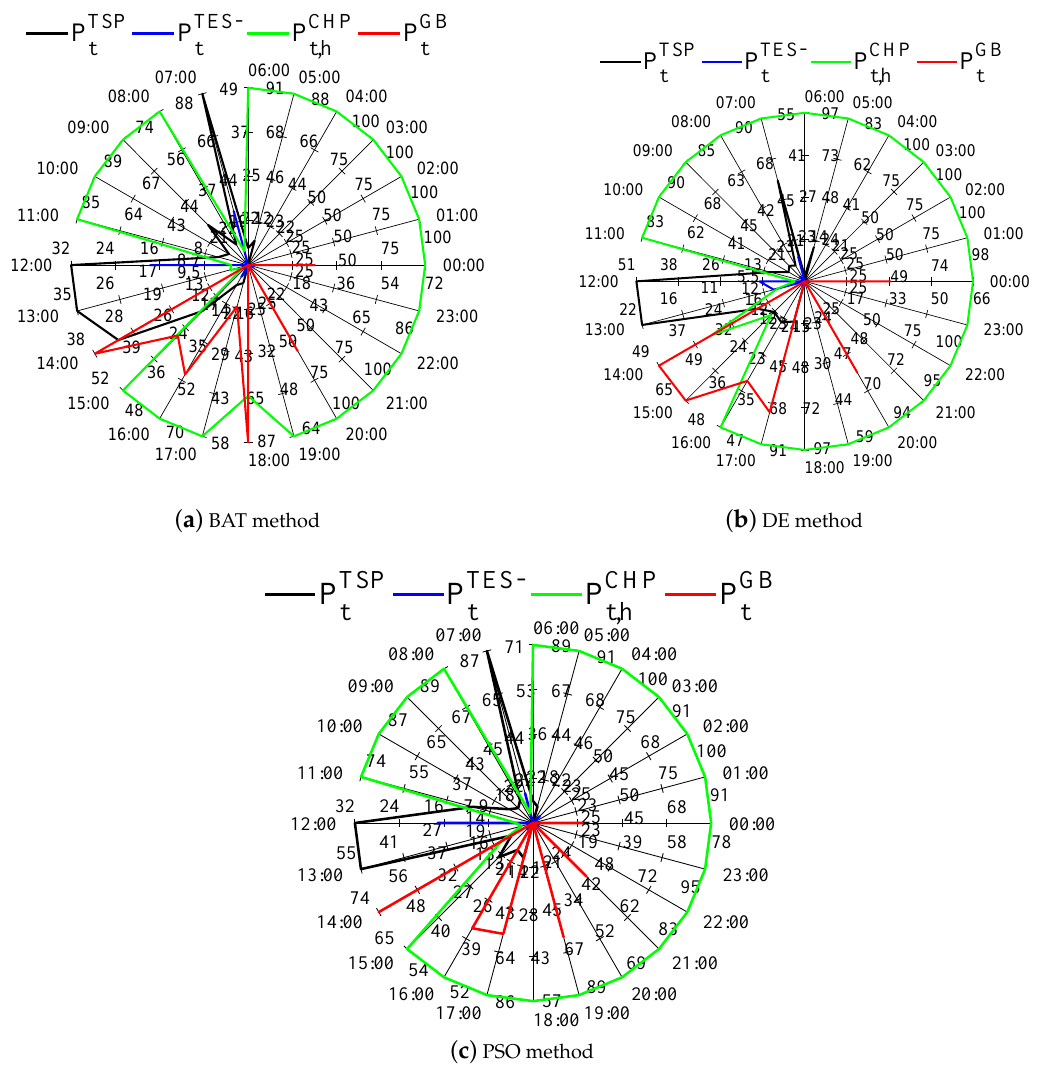
Figure 9. Percentage of thermal power produced by the implemented